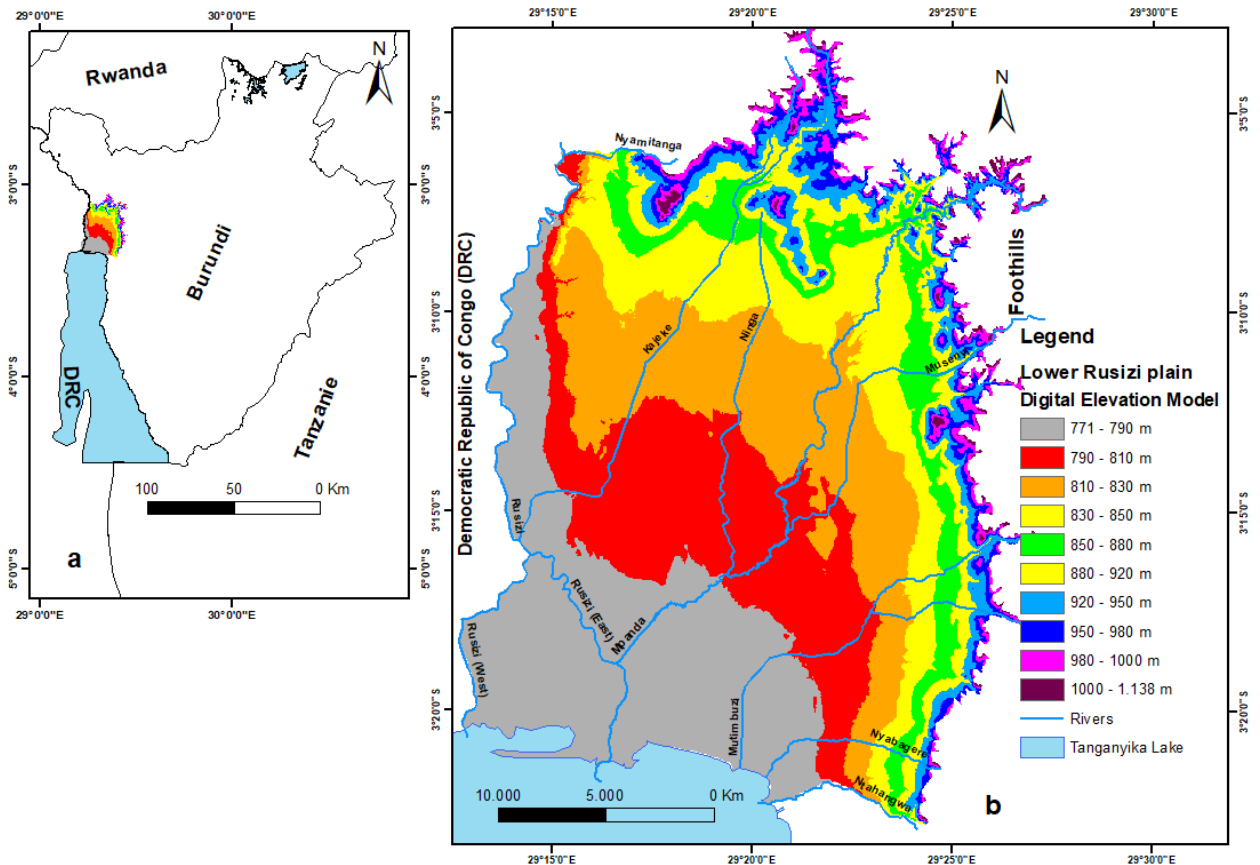
Figure 1. ( a ) Location map of the study area in Burundi; ( b ) limits of the lower Rusizi plain on the digital elevation model (10 m resolution) and presentation of the hydrographic network crossing the plain from the northeast to the southwest. Table 1. Stratigraphic description of the lower Rusizi plain. Age